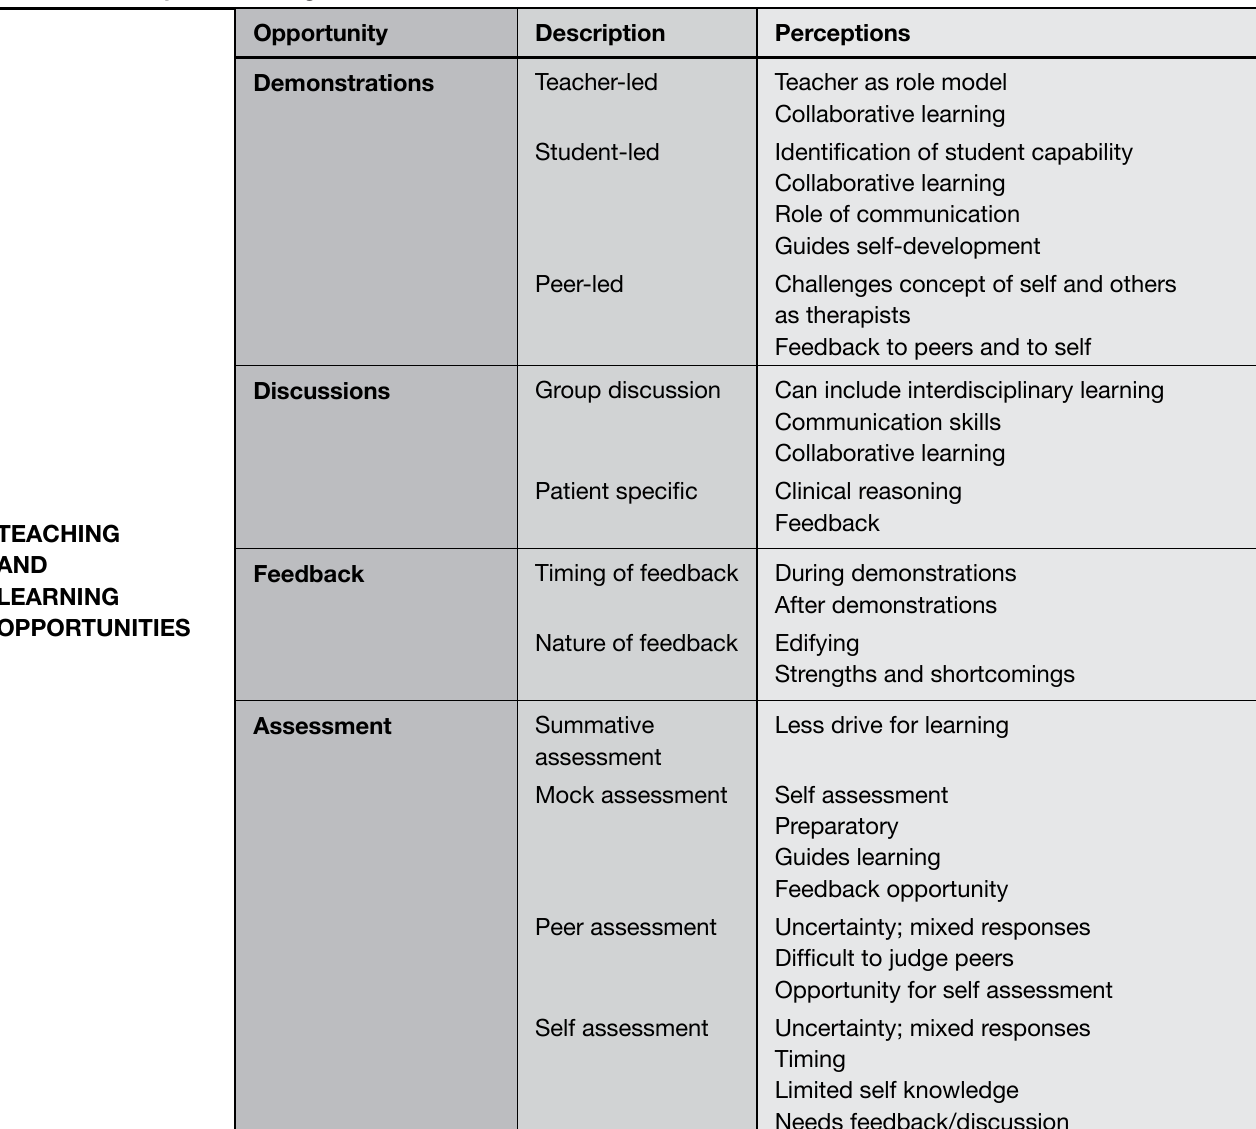
Table 2: Summary of themes generated from